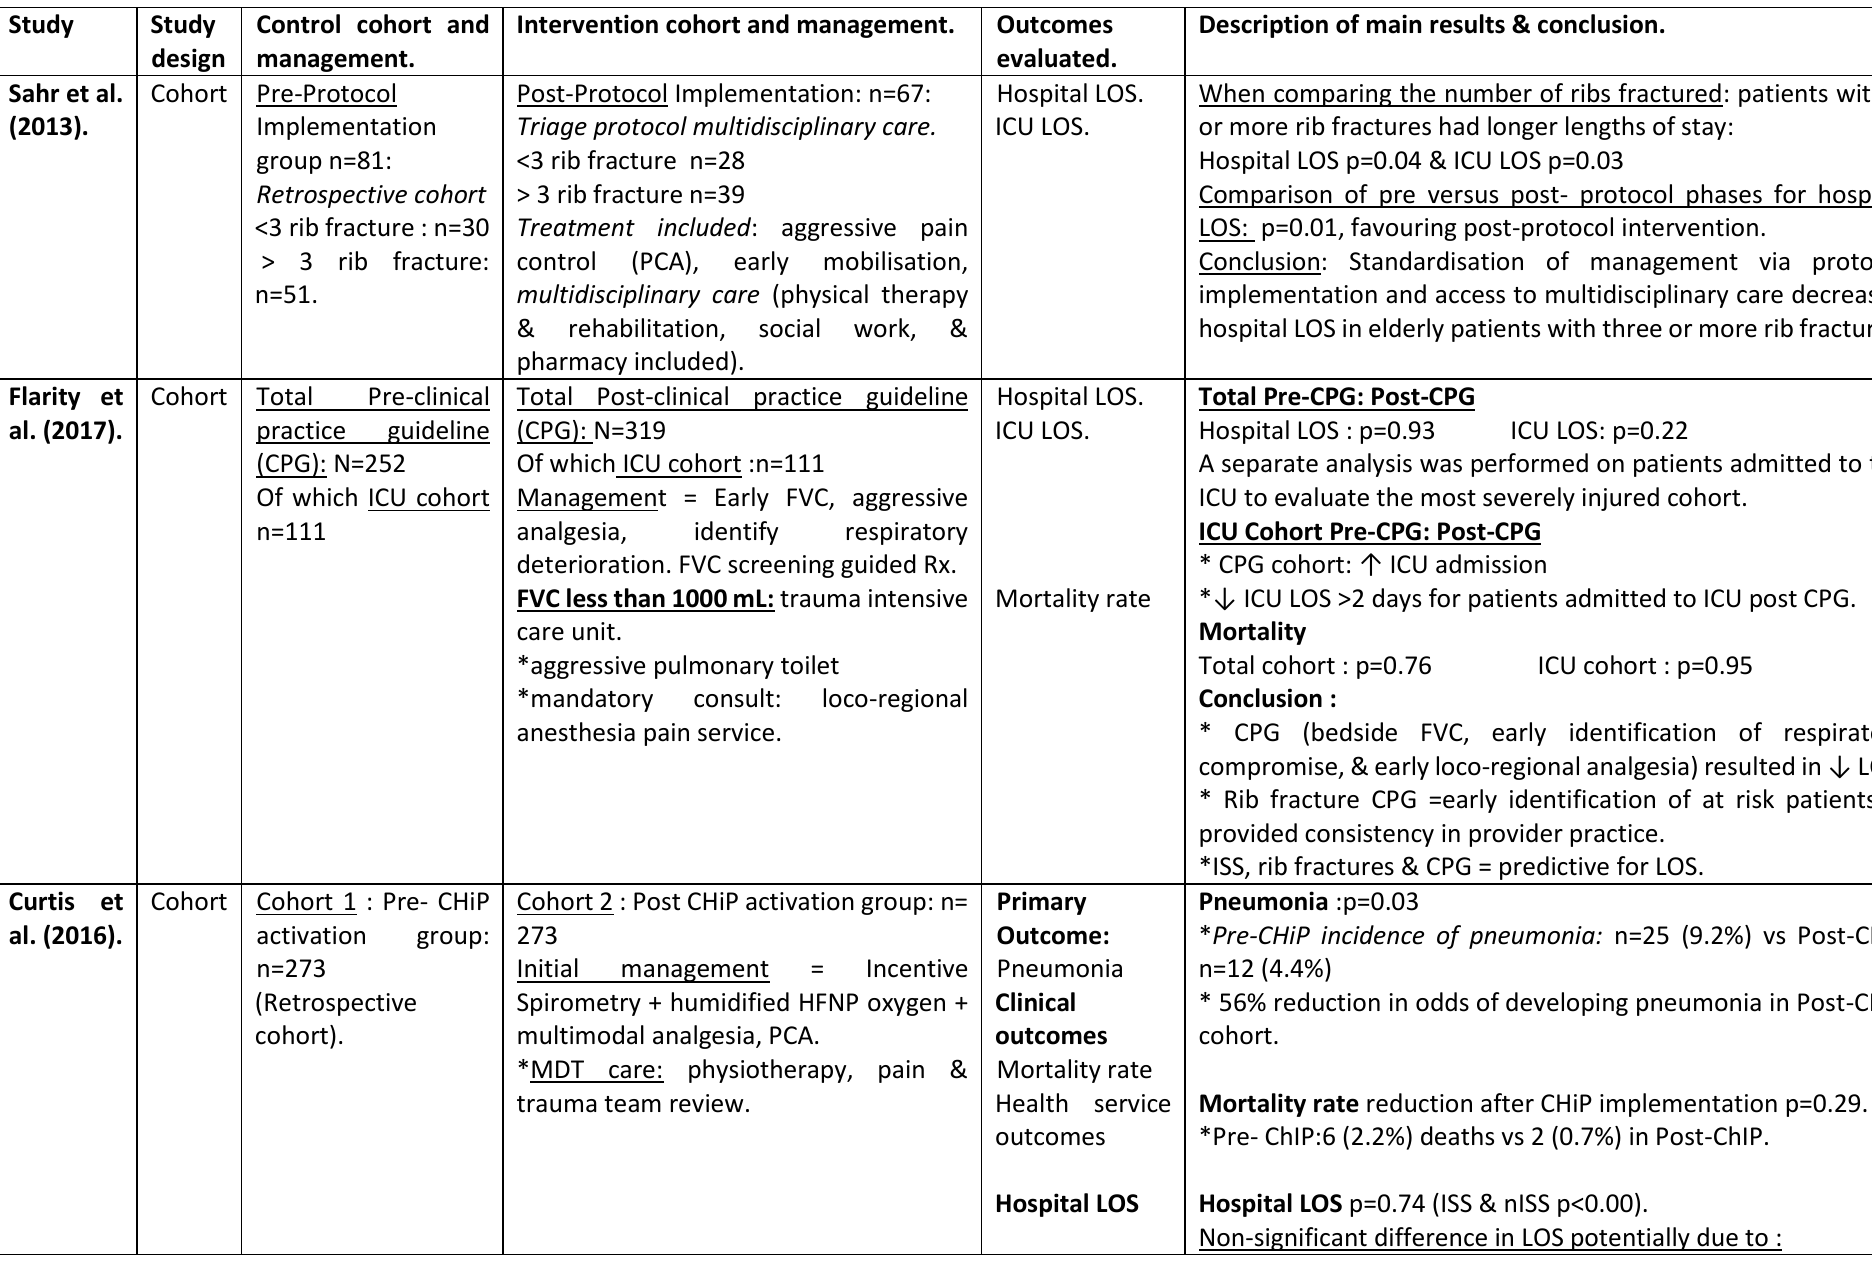
TABLE 13-A1: Interventions and outcomes of included cohort